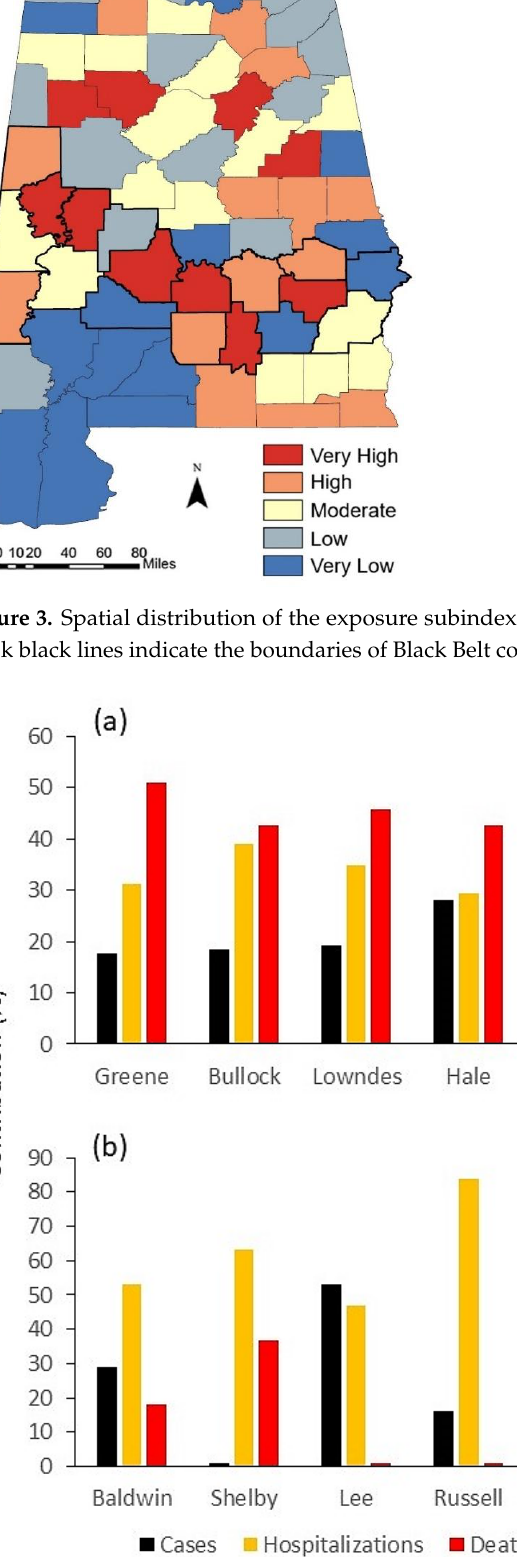
Figure 4. Percent contribution of each indicator to the exposure subindex for ( a ) the most exposed, and ( b ) least exposed counties. and ( b ) least exposed